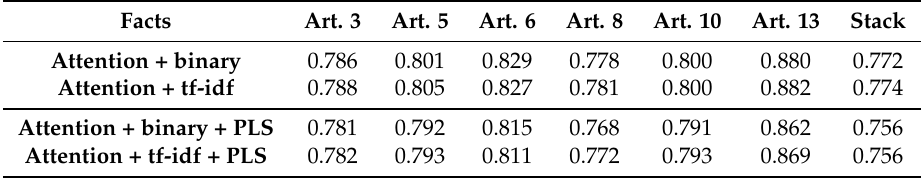
Table 10. Accuracy with tf-idf input on